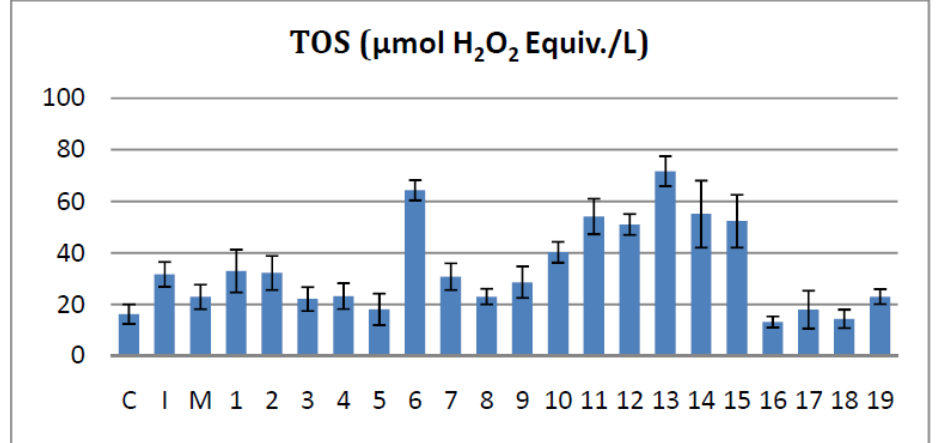
TOS = total oxidant status, C = negative control; I = inflammation; M =